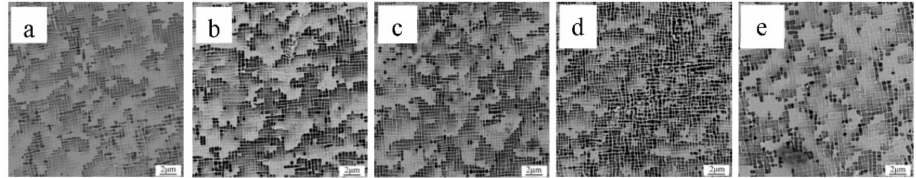
Figure 3. SEM images of γ ’ phase in each section of single crystal blade. ( a – e ) are the SEM images of the γ ’ phase in the S1–S5 transverse section, respectively.